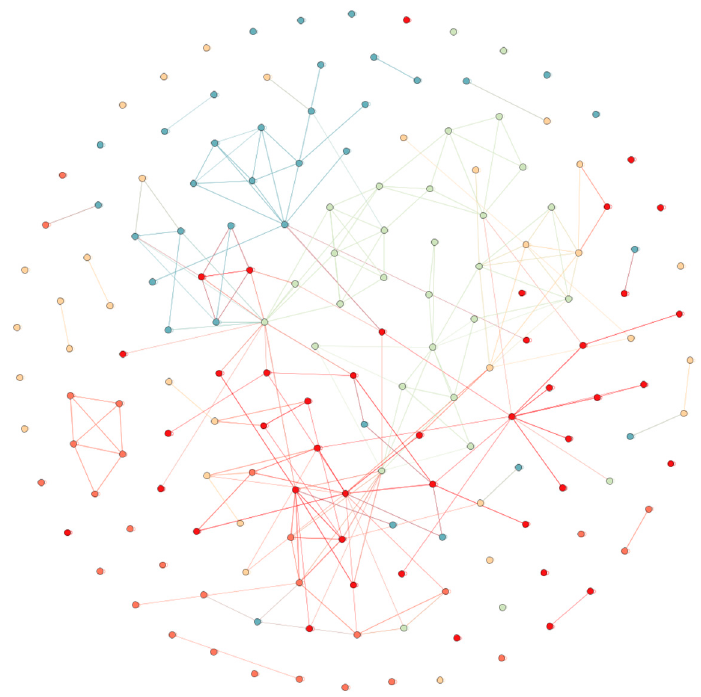
Figure 4. Collaboration network within College of Computer and Information Sciences (CCIS) in 2013.